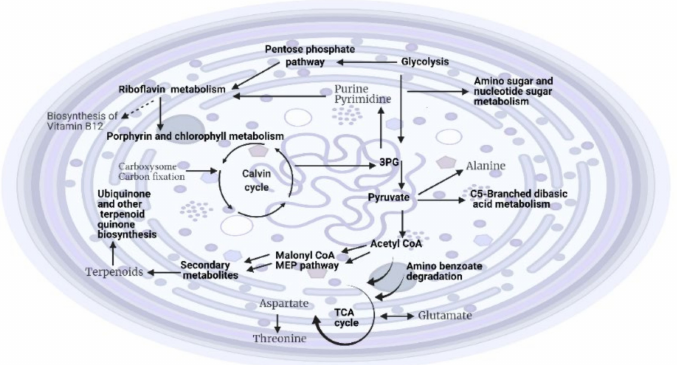
Figure 1. Cellular model representing the effects of light on the metabolic activities of Hapalosiphon sp. (MRB 220) based on metabolic profiling. The metabolites corresponding to pathways shown in the grey color were partially identified. Created with BioRender.com. (accessed on 4 August